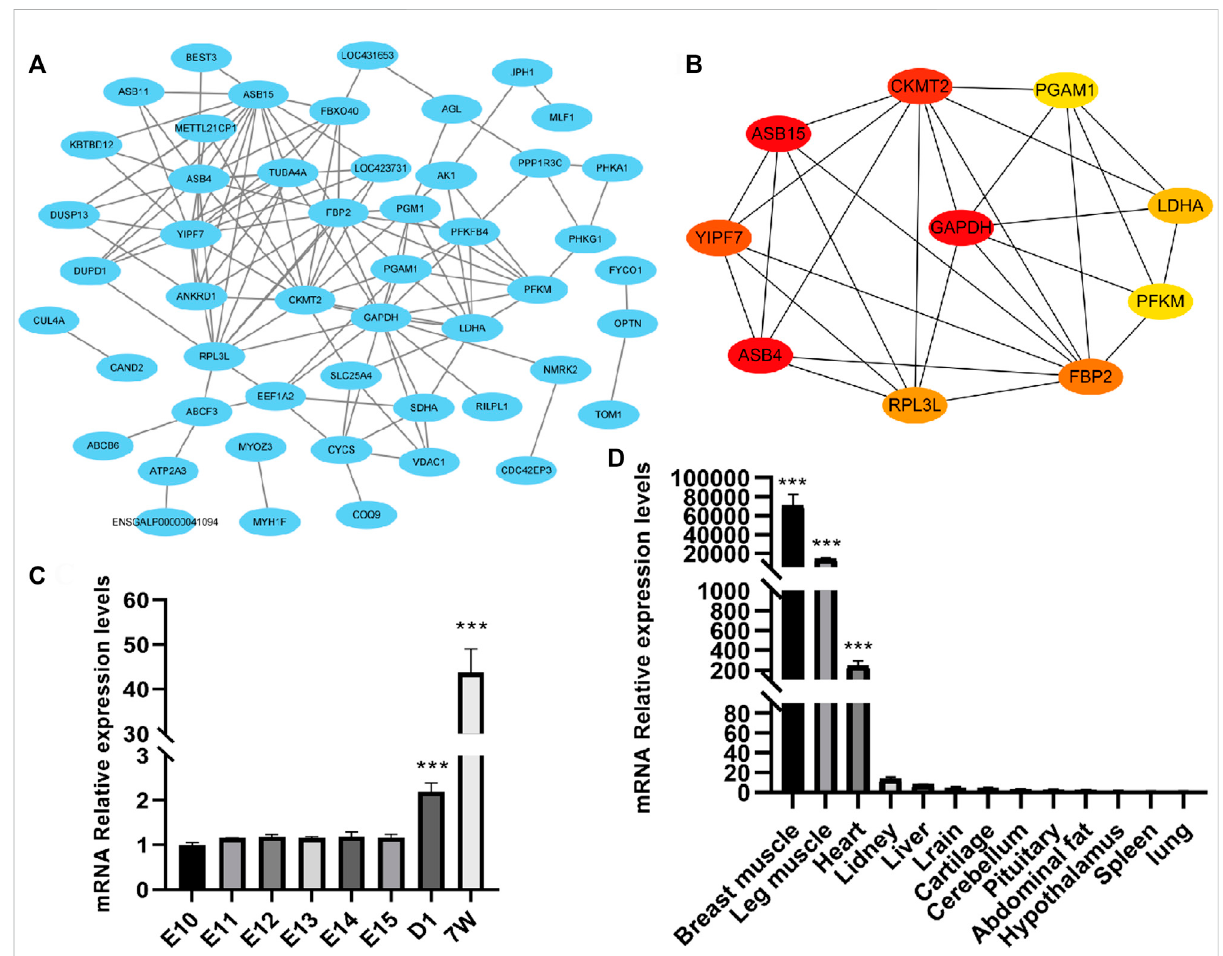
FIGURE 5 Protein – protein interaction (PPI) network analysis and validation of one of the hub genes RPL3L . (A) PPI network composed of differential genes; (B) top 10 hub genes according to the degree score; (C) expressed level of RPL3L in different developmental stages of the breast muscle of Xinghua chicken; and (D) expression level of RPL3L in different tissues of Xinghua chicken. *** p <